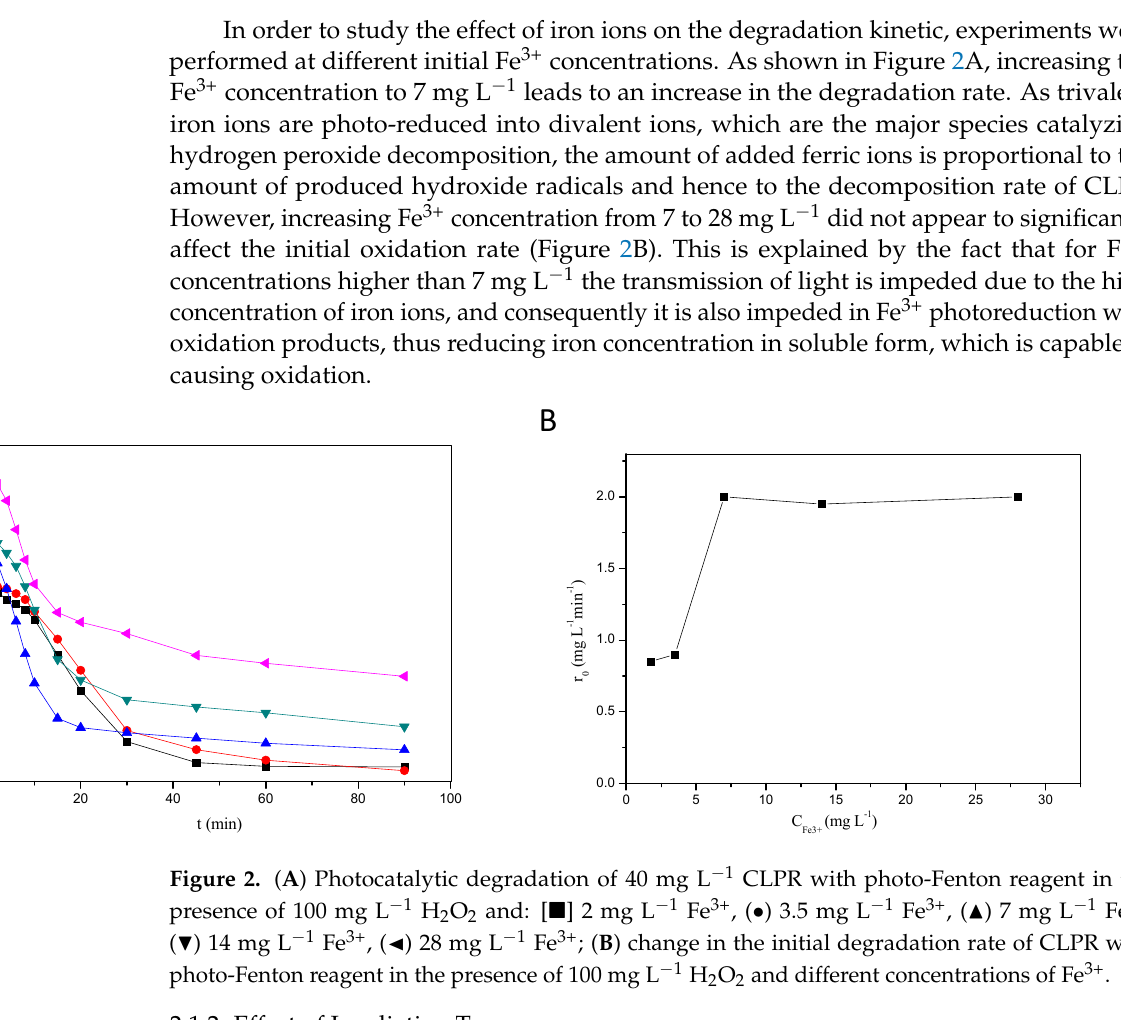
Figure 1. ( A ) Photocatalytic degradation of 40 mg L − 1 CLPR with photo ‐ Fenton reagent in the pres ‐ ence of 7 mg L − 1 Fe 3+ and different H 2 O 2 concentrations. [ ■ ] 200 mg L − 1 H 2 O 2 : ( ● ) 150 mg L − 1 H 2 O 2 , ( ▲ ) 100 mg L − 1 H 2 O 2 , ( ▼ ) 75 mg L − 1 H 2 O 2 , ( ◄ ) 50 mg L − 1 H 2 O 2 , ( ► ) 25 mg L − 1 H 2 O 2 , ( ♦ ) 0 mg L − 1 H 2 O 2 . ( B ) Change in the initial degradation rate of CLPR with photo ‐ Fenton reagent in the presence of 7 mg L − 1 Fe 3+ and different H 2 O 2 concentrations.